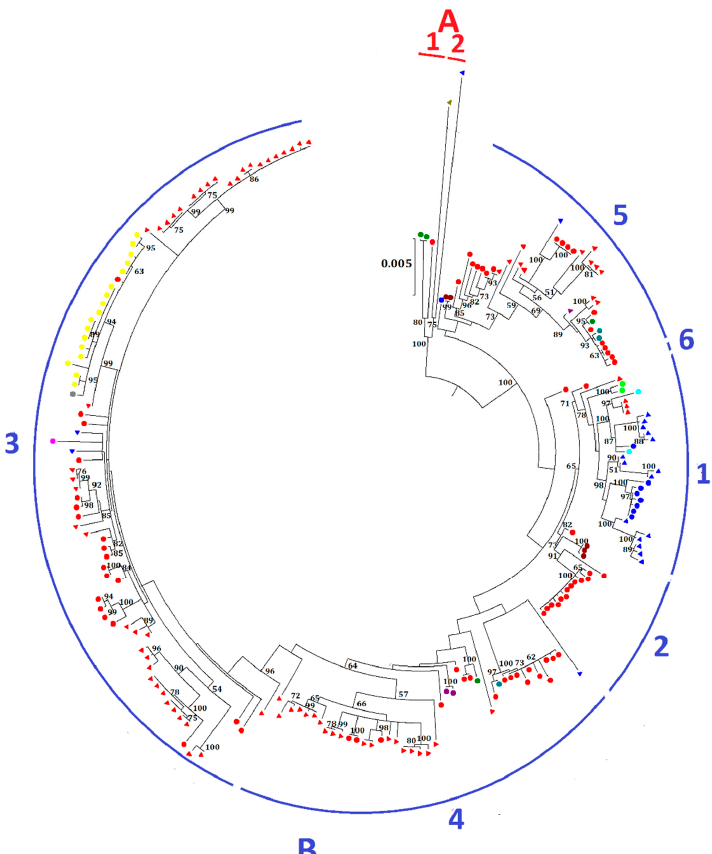
Figure 2. Maximum-likelihood phylogeny based on the complete genome sequences of 219 MERS-CoV strains. A general time-reversible model of nucleotide substitution with estimated base frequencies, the proportion of invariant sites, and the γ distribution of rates across sites were used in the maximum-likelihood analysis. Bootstrap values in percentage are shown next to the branches. The scale bar indicates the number of nucleotide substitutions per site. Different colored letters and numbers represent different clades and lineages respectively: red letter, clade A; red number, lineages within clade A; blue letter, clade B; blue numbers, lineages within clade B. MERS-CoVs from dromedaries and humans are indicated in triangles and circles, respectively. Different colors represent MERS-CoV strains found in different countries: red, Saudi Arabia; blue, United Arab Emirates; green, Jordan; olive, Egypt; maroon, United Kingdom; purple, Qatar; teal, United States; lime, France; aqua, Oman; fuchisa, Thailand; grey, China; yellow, South Korea. Fifteen MERS-CoV strains, including six from human and nine from dromedaries, fell into different lineages in the phylogenetic trees constructed using ORF1ab and S (Table 1 and Figure 3), suggesting possible recombination events. For example, four MERS-CoV strains from dromedaries